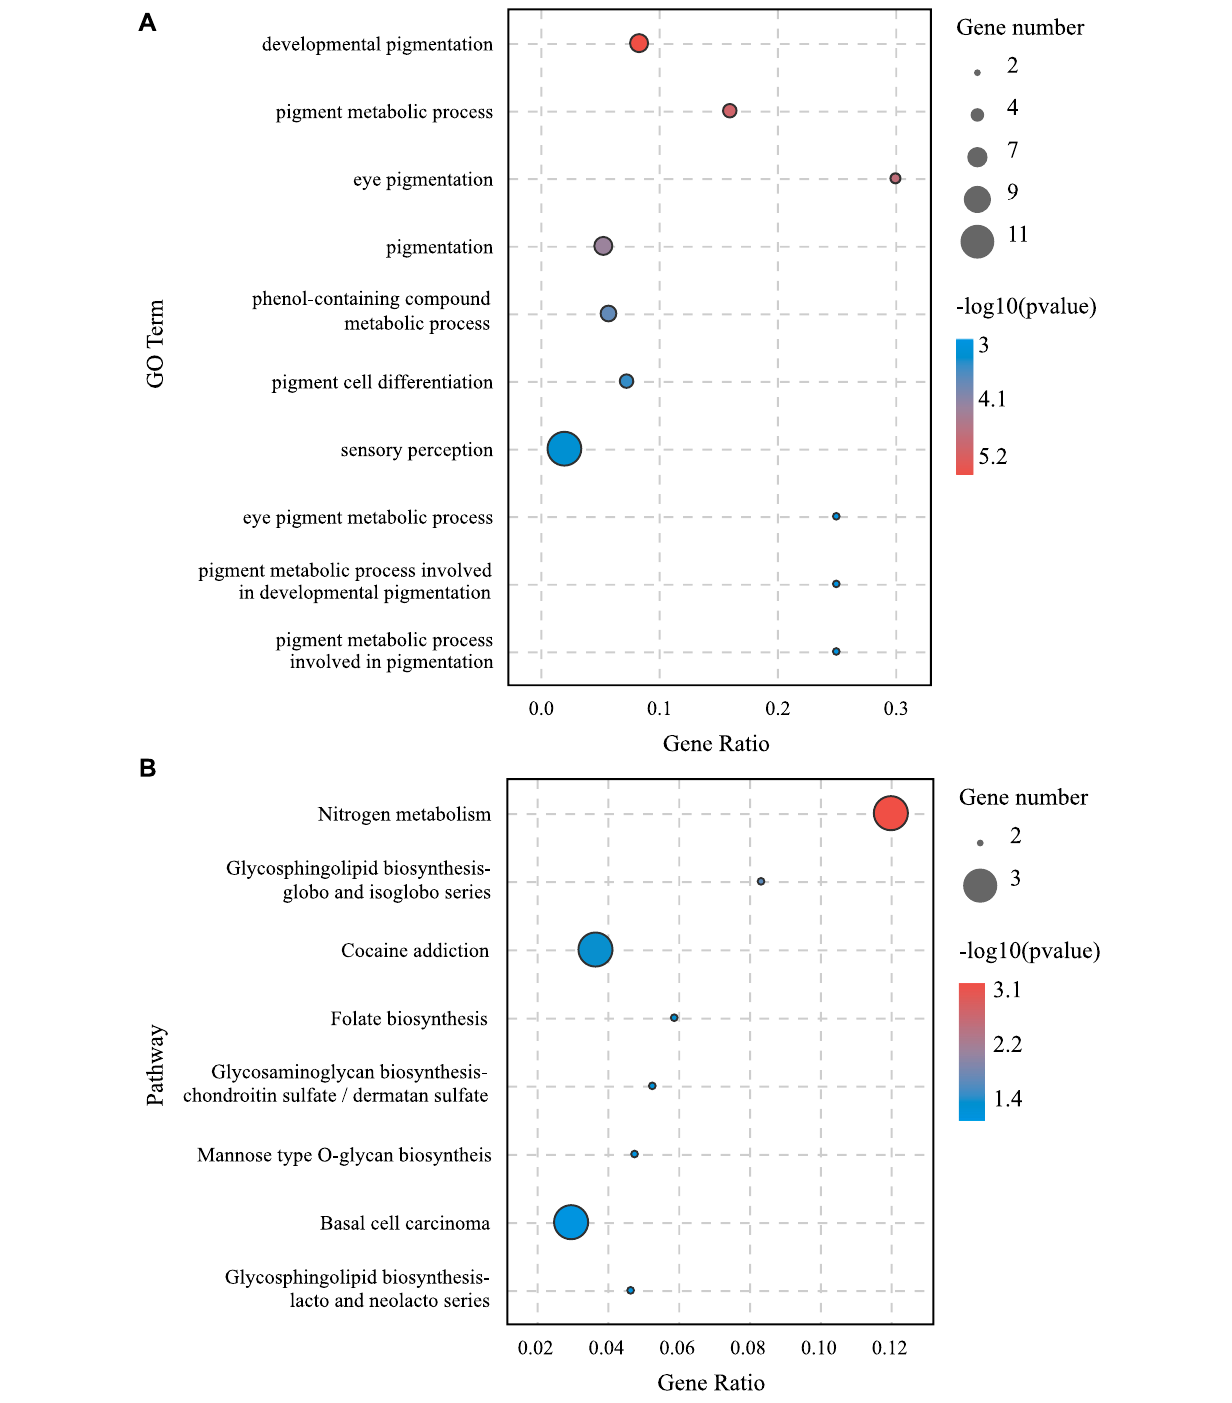
Frontiers in Genetics |